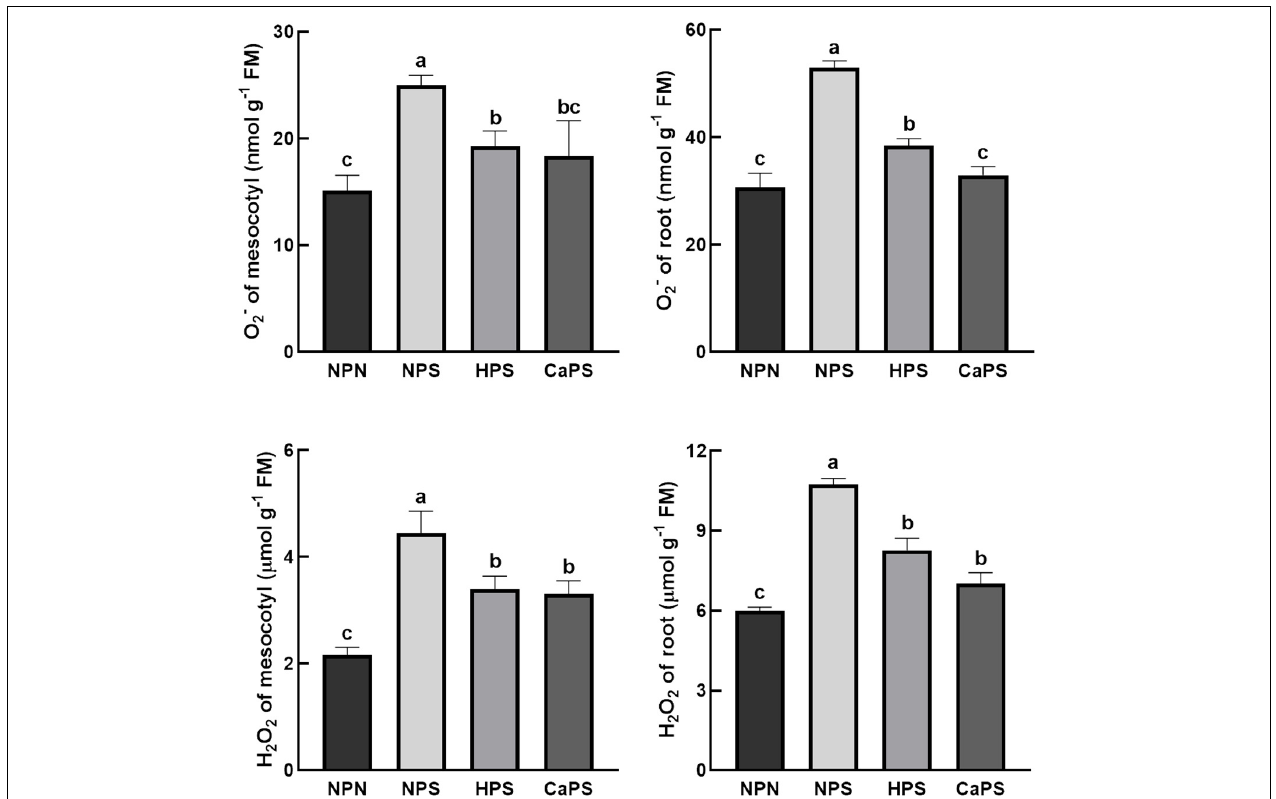
FIGURE 4 | Effect of CaCl 2 priming on reactive oxygen in sorghum tissue under salt stress.